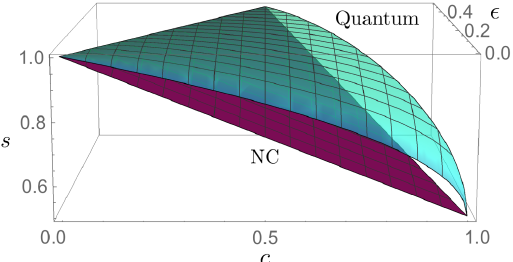
FIG. 5. Maximum success rate achievable in a noncontextual model (purple surface), and quantumly acheivable success rate (light blue